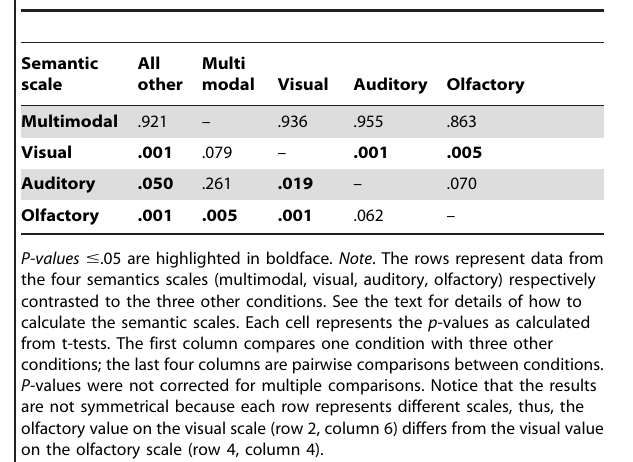
Table 1. P-values showing differences between conditions (columns) on four semantic scale (rows).